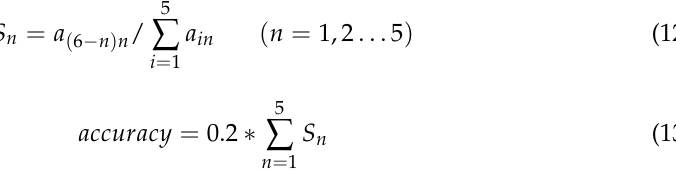
Figure 6. Presentation of the electrophysiological signals in diverse eye movement states. ( a ) EOG signal. ( b ) Strain signal.